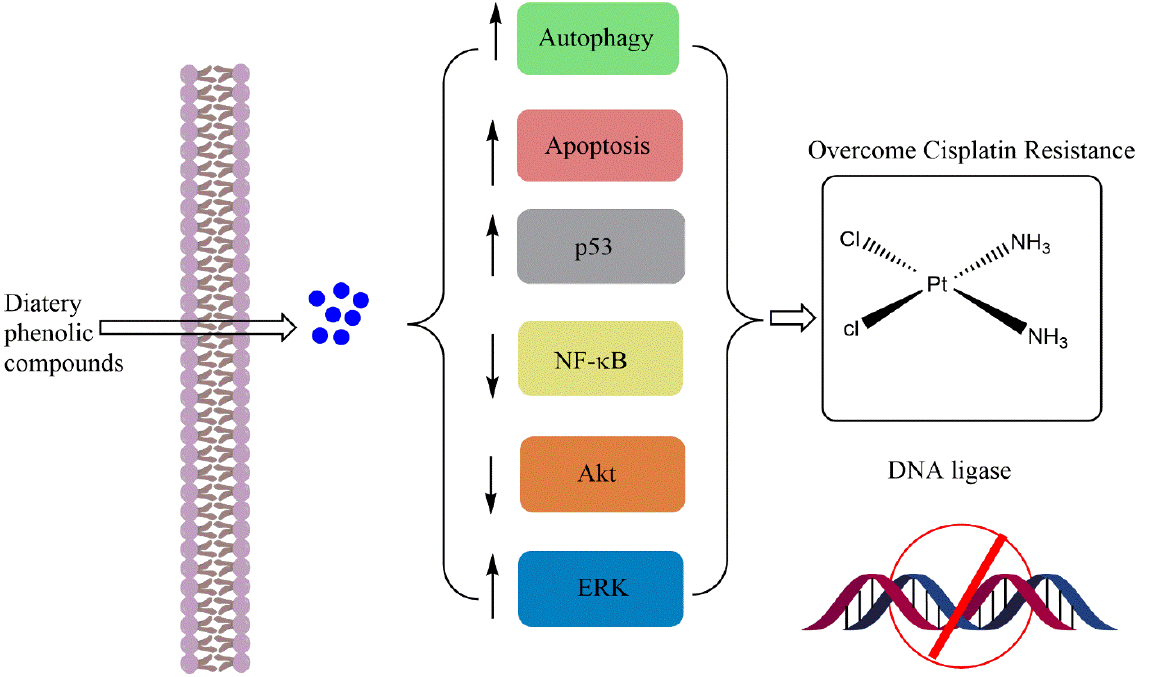
Figure 3. Mechanisms of chemosensitivity of apigenin towards sisplatin.